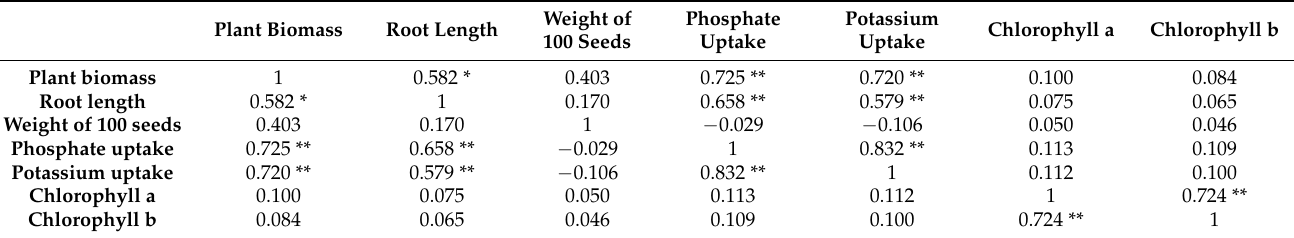
Table 6. Correlation between observation